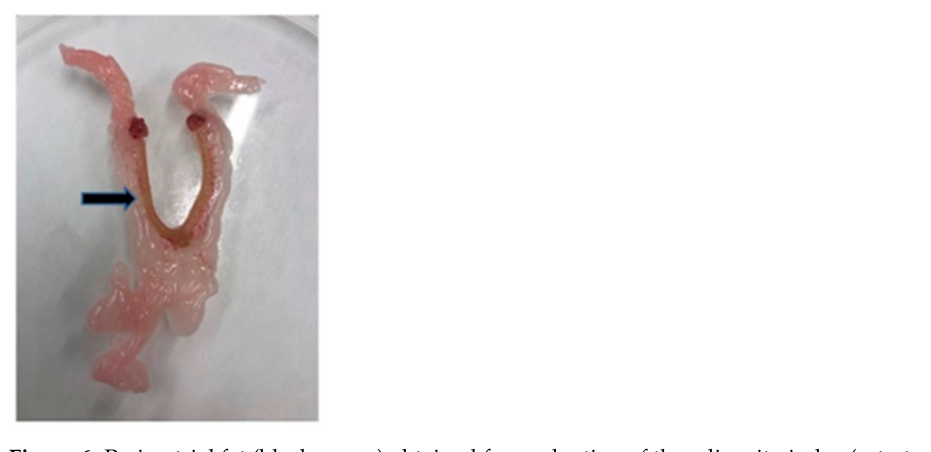
Figure 6. Perimetrial fat (black arrow) obtained for evaluation of the adiposity index (rat uterus).